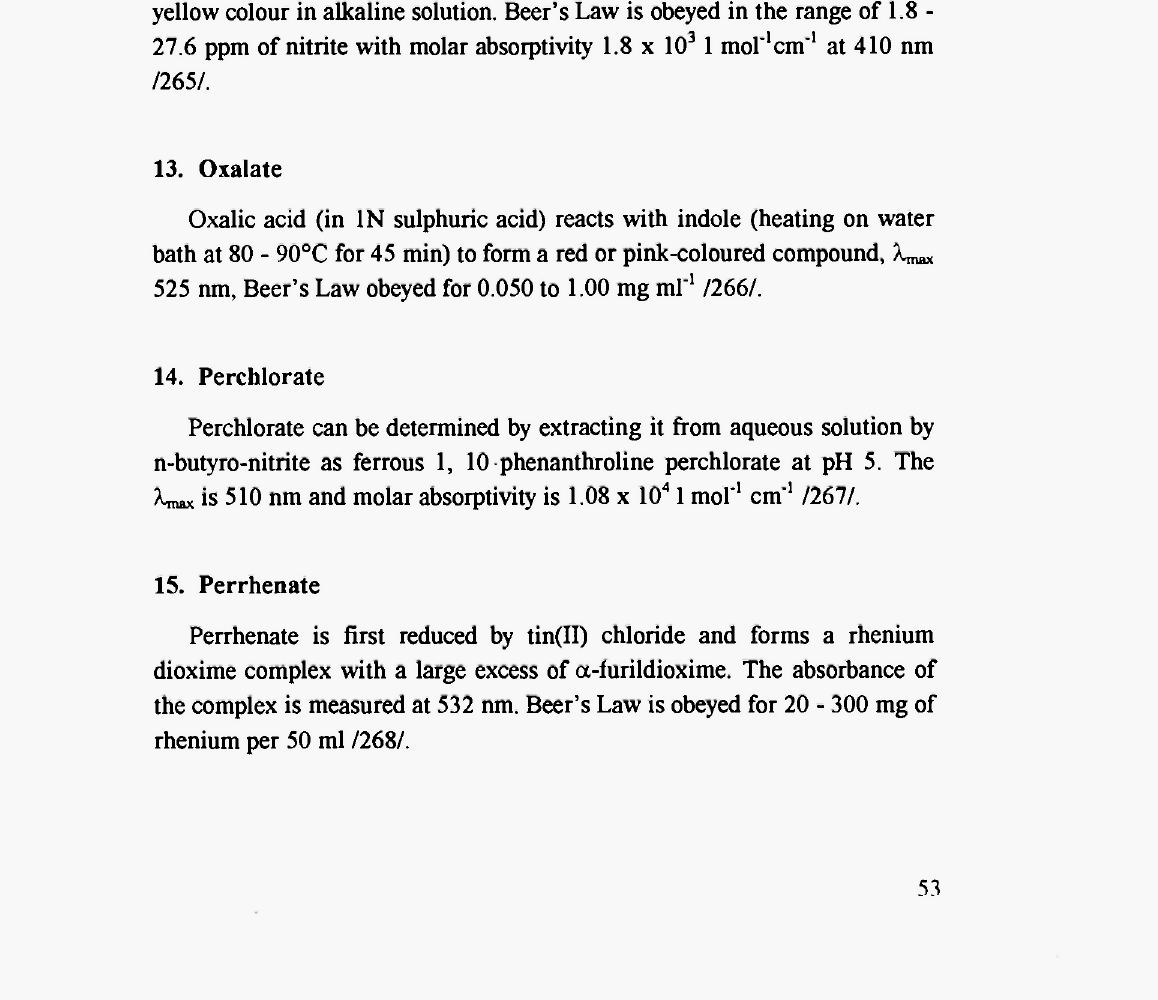
12. Nitrite Nitrite reacts with salbutamol sulphate in acidic medium, which gives a yellow colour in alkaline solution. Beer's Law is obeyed in the range of 1.8 - 27.6 ppm of nitrite with molar absorptivity 1.8 χ 10 3 1 mol 'cm" 1 at 410 nm /265/.